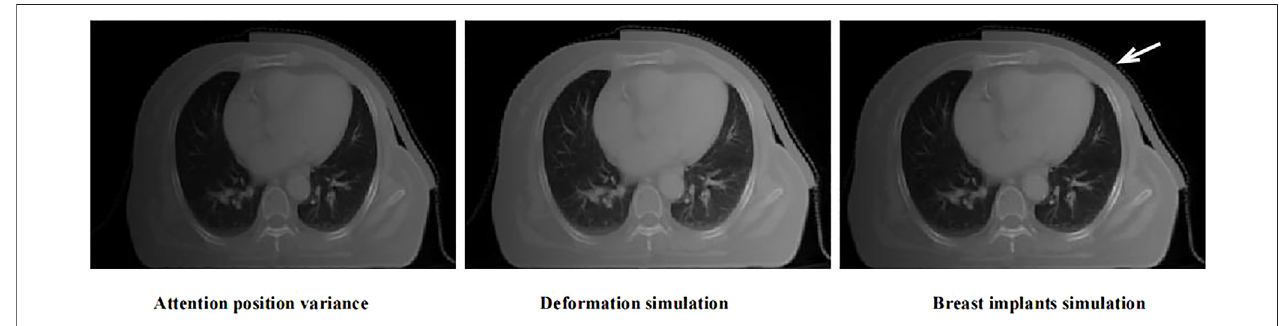
FIGURE 2 | The examples of the proposed data augmentation strategies. The red arrow indicates the position of implanted breast